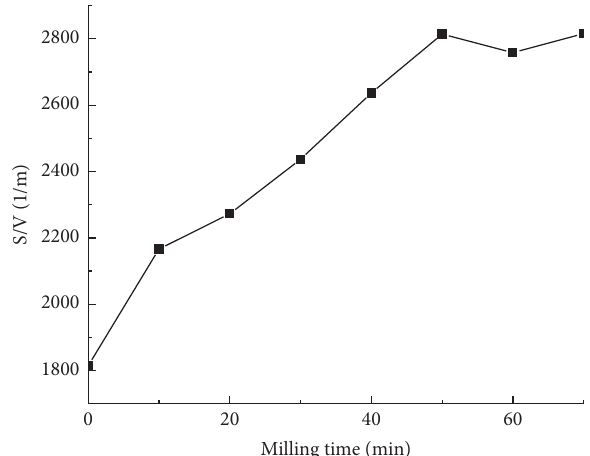
Figure 10: Variation of the specific surface area of PBG.